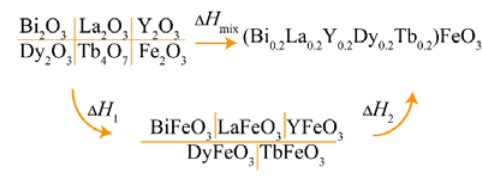
Fig. 3 Flow chart of Δ H mix calculation.